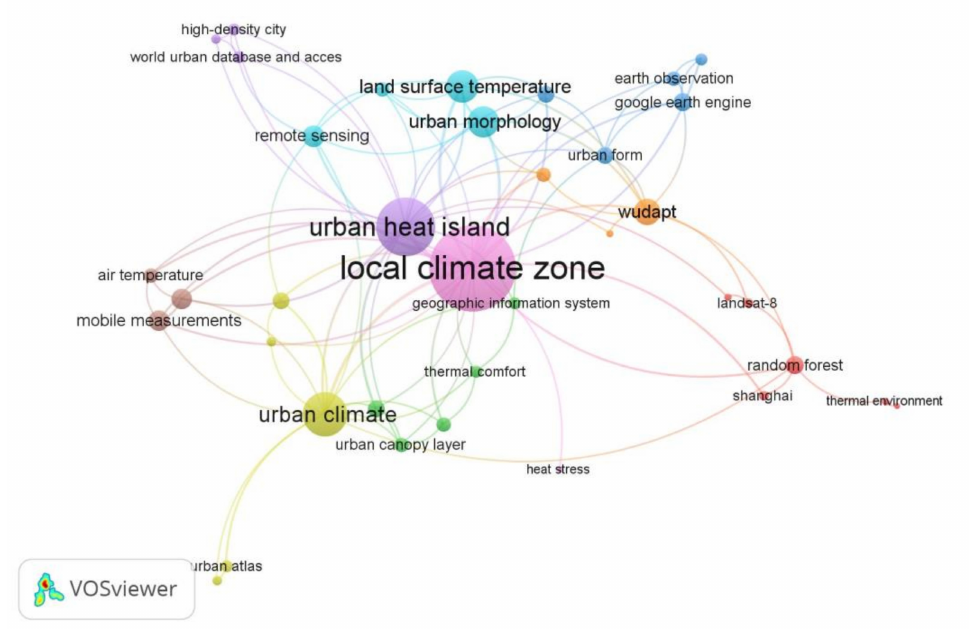
Figure 6. Author keyword co-occurrence analysis in selected articles.